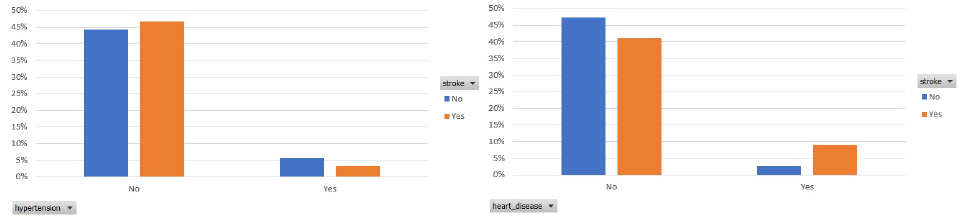
Figure 2. Participants distribution per hypertension and heart disease status in the balanced dataset.